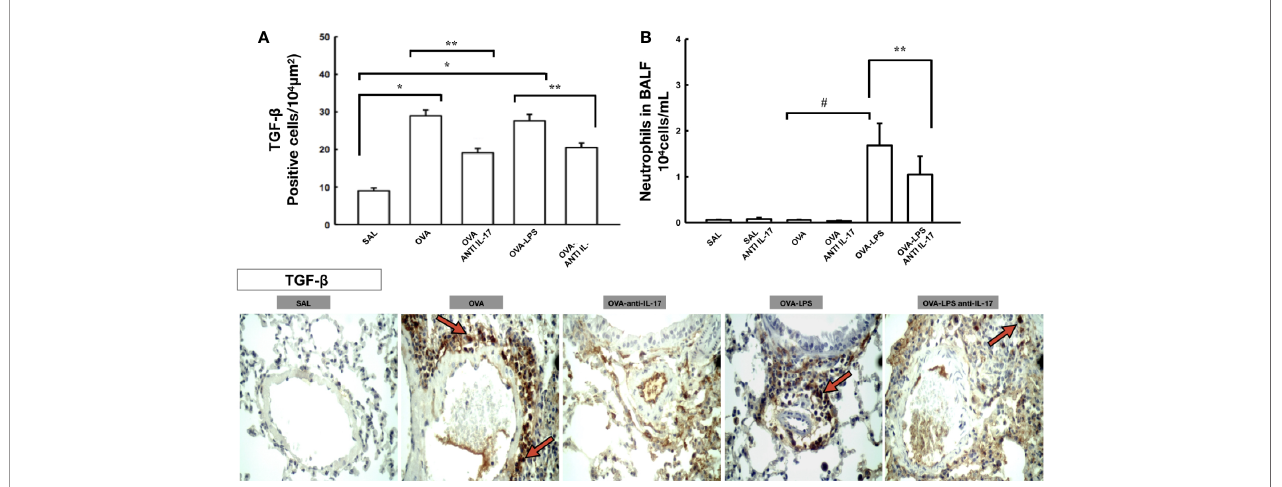
FIGURE 4 | Effects of anti-IL 17 treatment on TGF- b and neutrophils in BALF. Panel A shows the expression of positive cells for TGF- b in the pulmonary vessels and Panel B shows the number of neutrophil cells in the bronchoalveolar lavage fl uid. The values represent the mean ± SE of TGF- b and neutrophils for all experimental groups. The differences were considered signi fi cant when p<0.05. *p<0.05 vs. SAL group; **p<0.05 vs. OVA and OVA – LPS groups. # p<0.05 vs. OVA group. Photomicrograph pulmonary vessels measuring TGF- b . The animals exposed to only ovalbumin and ovalbumin plus LPS (OVA and OVA – LPS groups) presented prominent increases in the numbers of positive cells, compared with the control animals (SAL group). Anti-IL-17 treatment in the OVA anti-IL-17 and OVA – LPS anti-IL-17 groups ameliorated all increases in these markers. The red arrows indicate the positive cells for TGF- b .